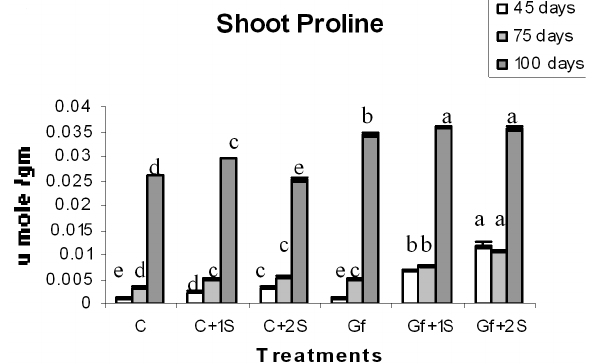
Fig. 4. Shoot proline content in Gmelina arborea Roxb inocu- lated with Glomus fasciculatum after 45, 75 and 100 days after AM inoculation